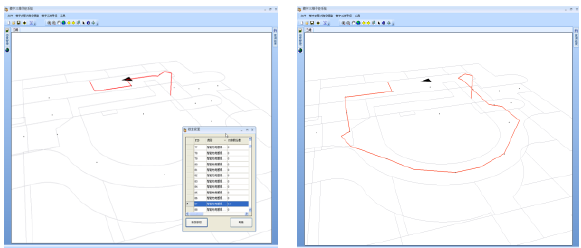
Figure 11 Seneor alerting and route